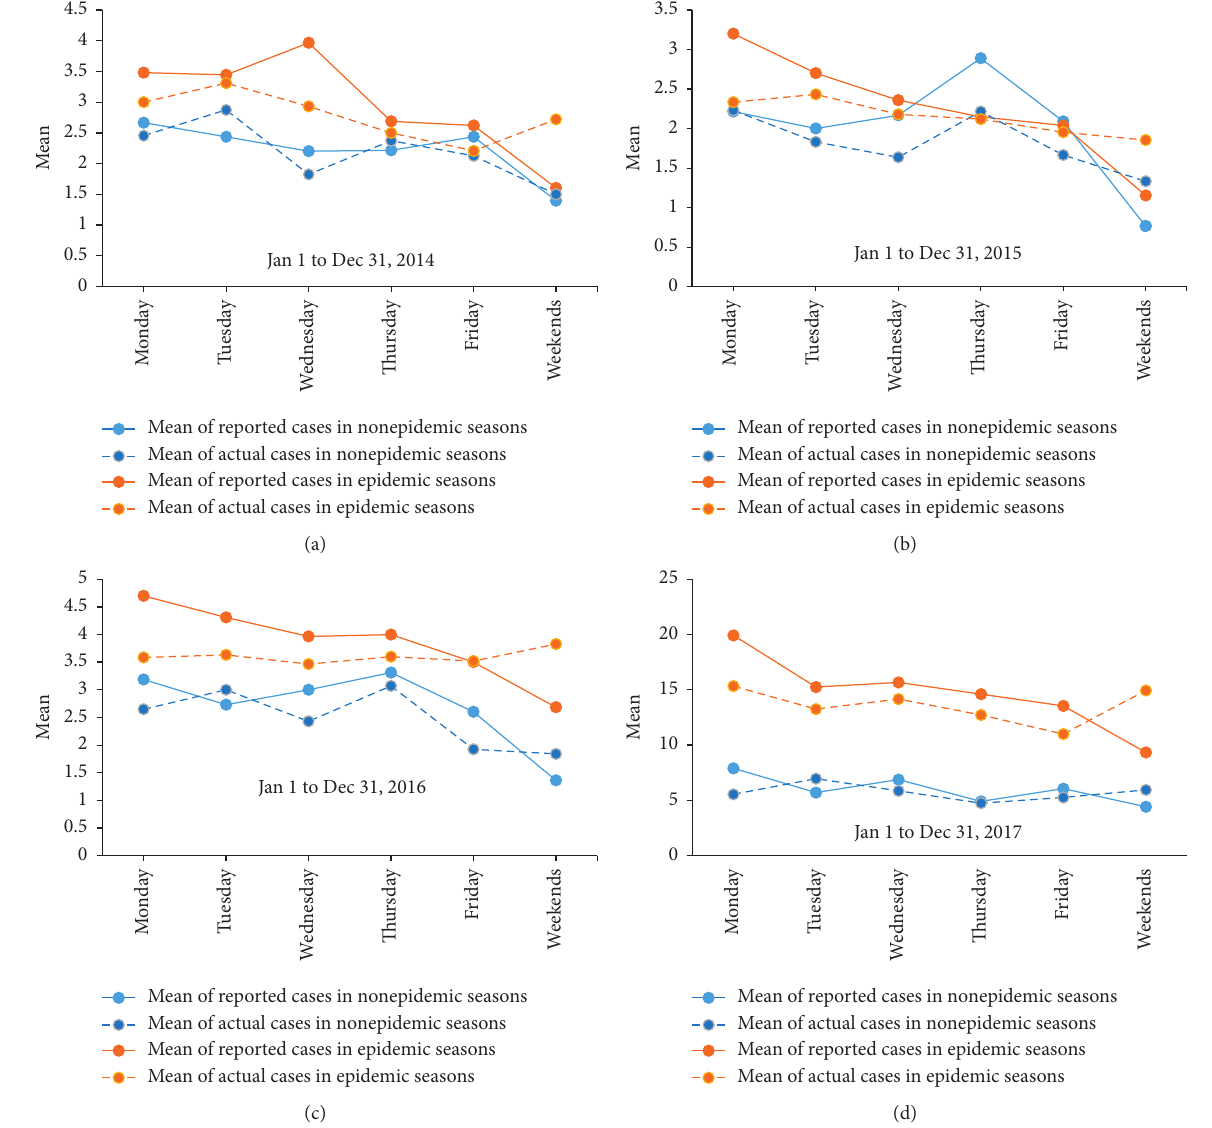
Figure 2: Distribution of weekly average actual cases and reported numbers of epidemic parotitis cases between 2014 and 2017 in Hanzhong city,